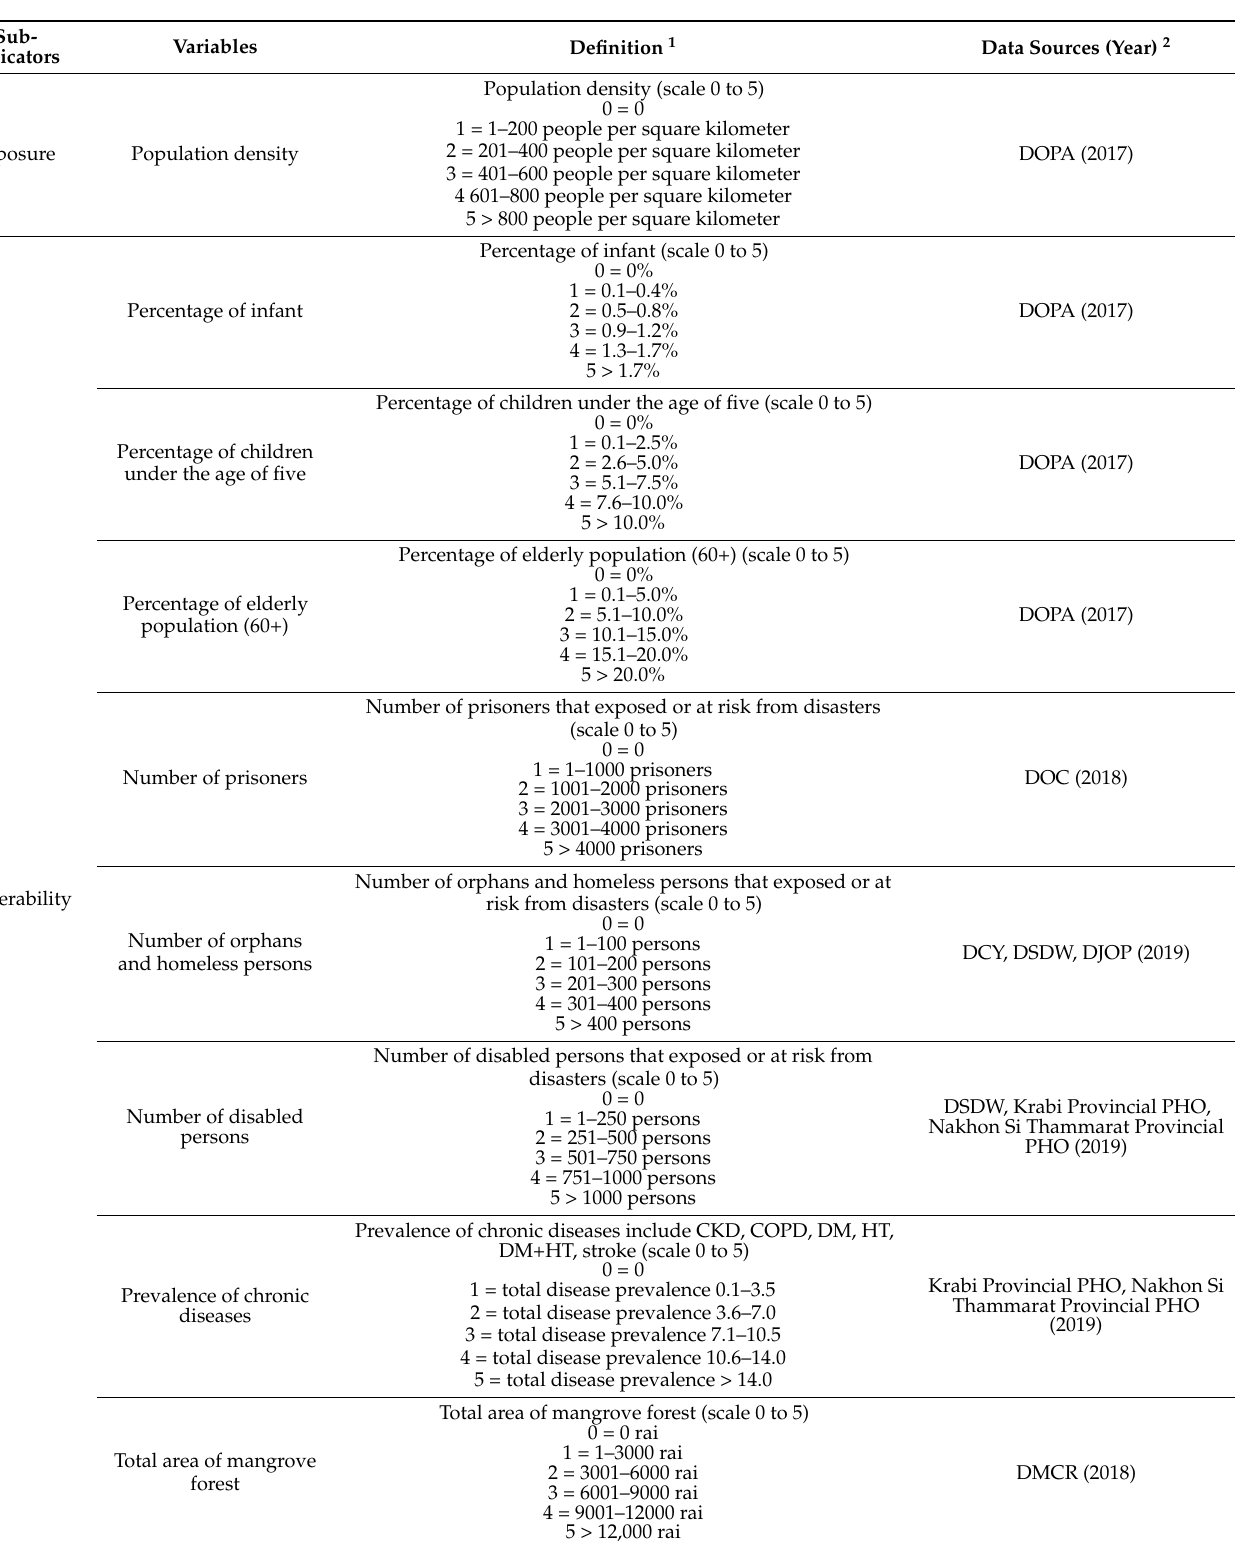
Table 2. Variables used to measure disaster